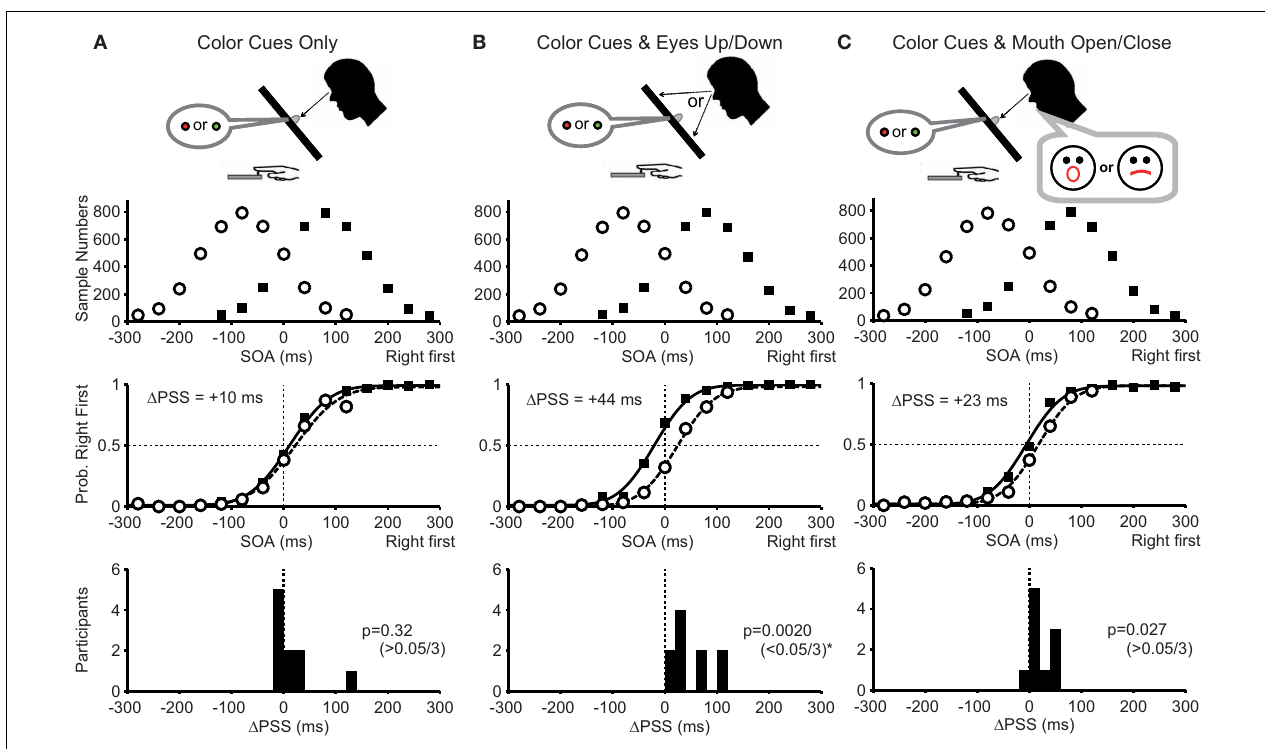
psychometric functions in (B) away from the peaks of two prior distributions as predicted by the Bayesian estimation theory. Separation between two psychometric functions, or the difference between the two points of subjective simultaneity ( ∆ PSS), is shown in each panel.The bottom panels show the number of participants as a function of the PSS difference calculated for each participant.The Bayesian estimation theory predicts positive PSS differences.The P -value of theWilcoxon signed-rank test, under the null hypothesis that the median was zero, is shown in each panel.The level of significance was set to 0.05/3 (Bonferroni